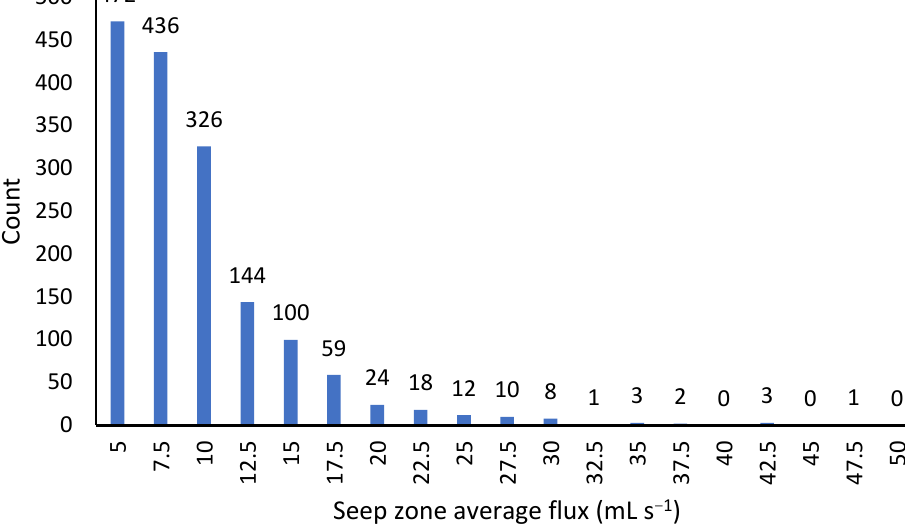
Figure 9. Frequency distribution of average flux of seep zones.